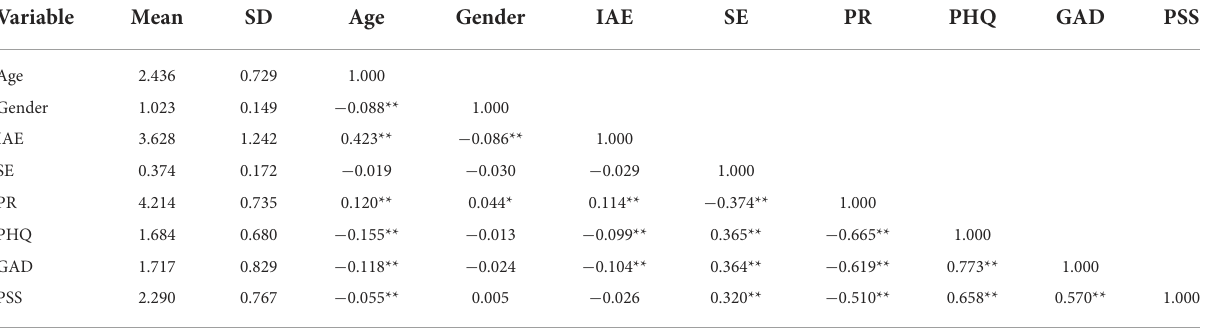
TABLE 4 Descriptive statistics and correlations between